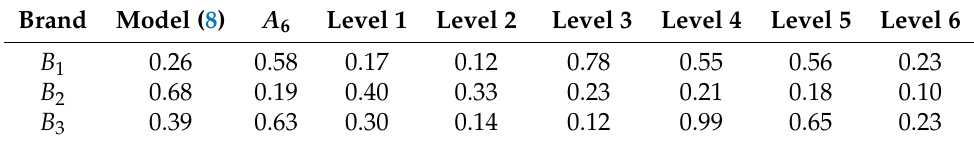
Table 7. Residue for model (8) and (9) estimates at different